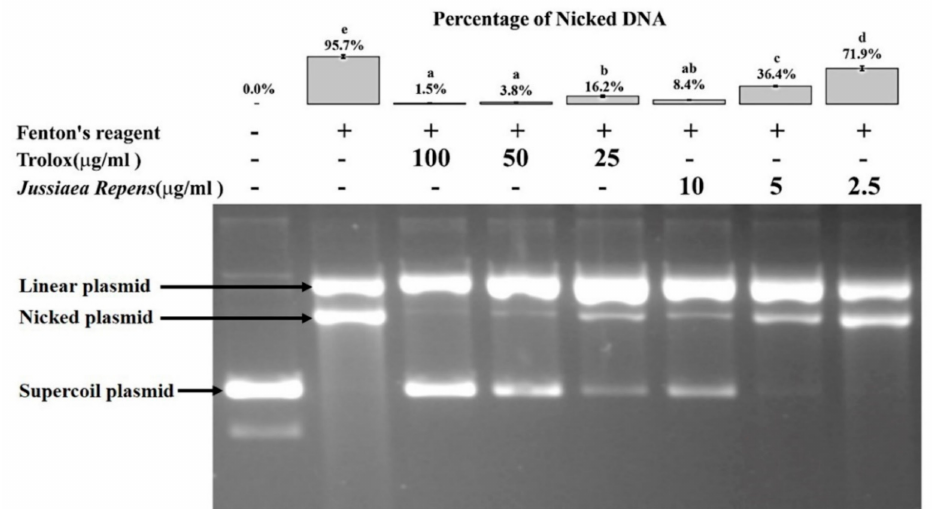
Figure 1. In vitro DNA protection capacity of Jussiaea repens L. The in vitro DNA protection capacity of J. repens L. from hydroxyl radicals. The bar graph represents the percentage (Mean ± SEM) of nicked from plasmid produced due to Fenton’s reagent. The values with the same alphabet are not statistically significant at a 5% level of significance according to Tukey’s HSD